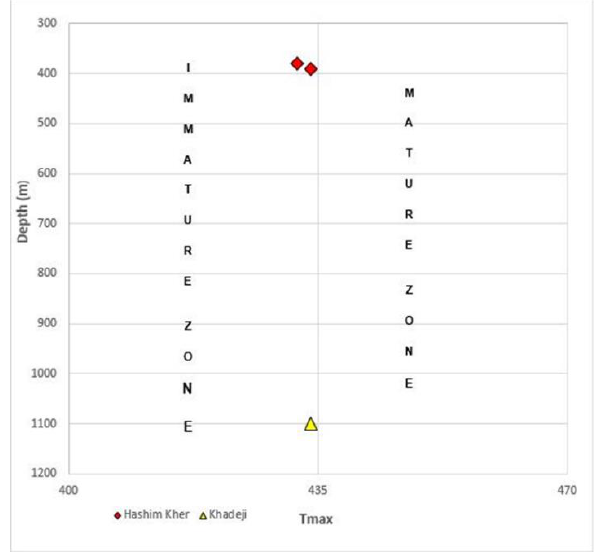
Figure 5: Plot of Tmax versus depth for Laki shales (diagram boundaries are after Tissot and Welte, 1984; Peters and Cassa, 1994).